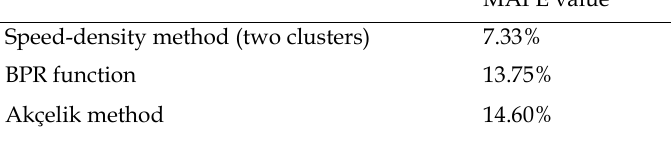
Case study II MAPE values of the selected travel time prediction